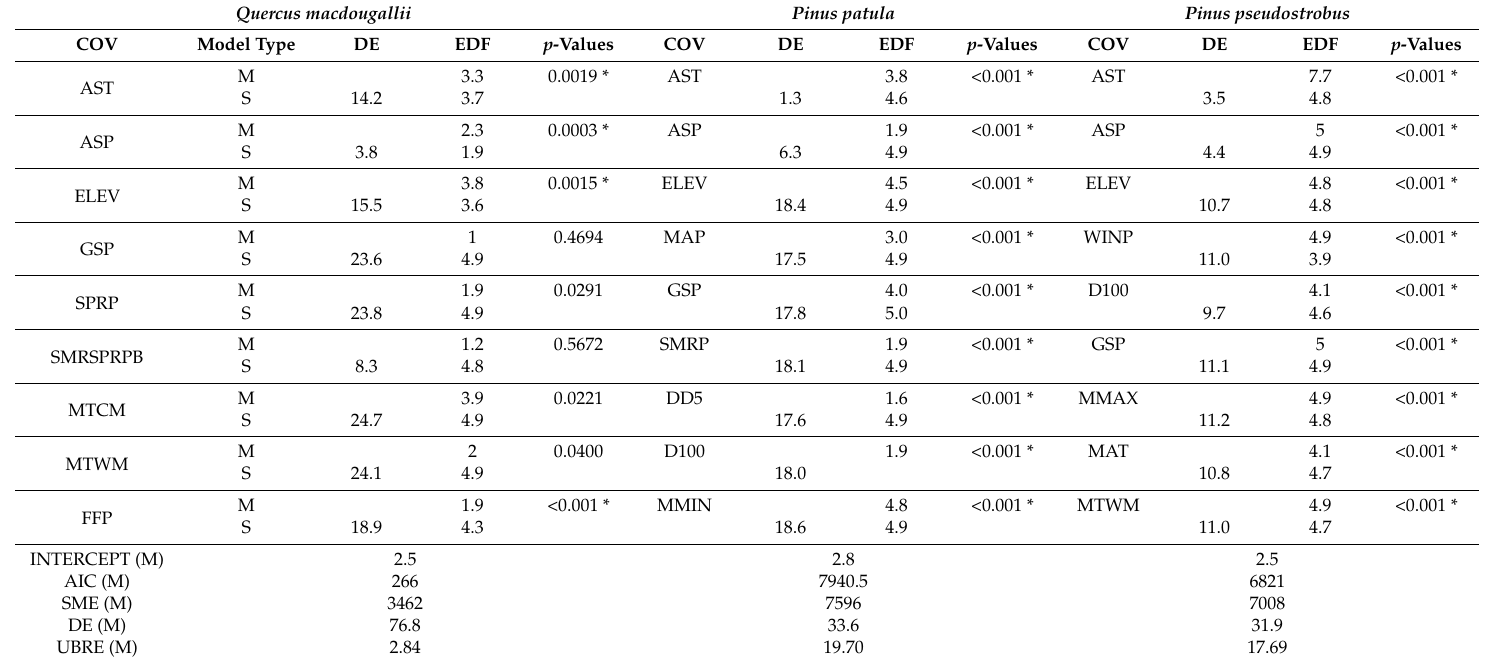
Table 3. Estimated degrees of freedom and adjustment indicators of the GAM